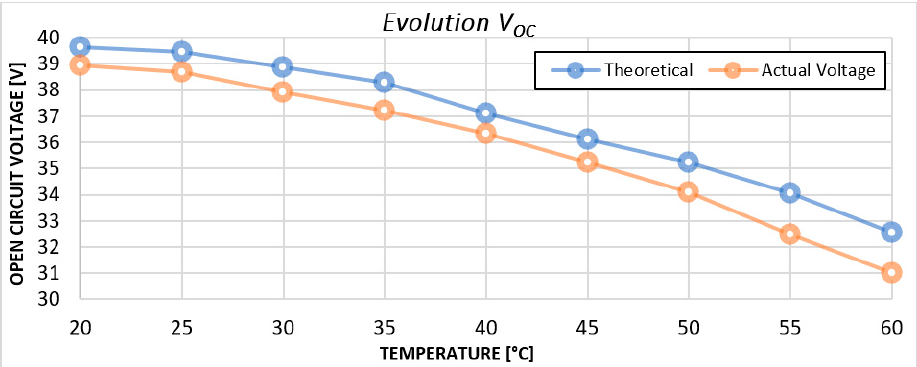
Figure 6. Plot representation of the temperature influence to the V OC characteristics of the PV gen- erator.